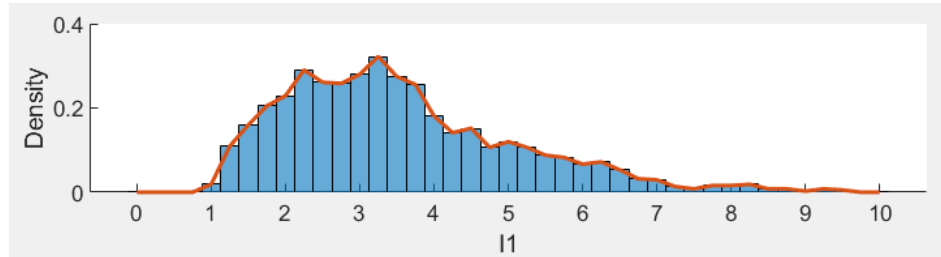
Figure 9. Histogram of the probability density function of